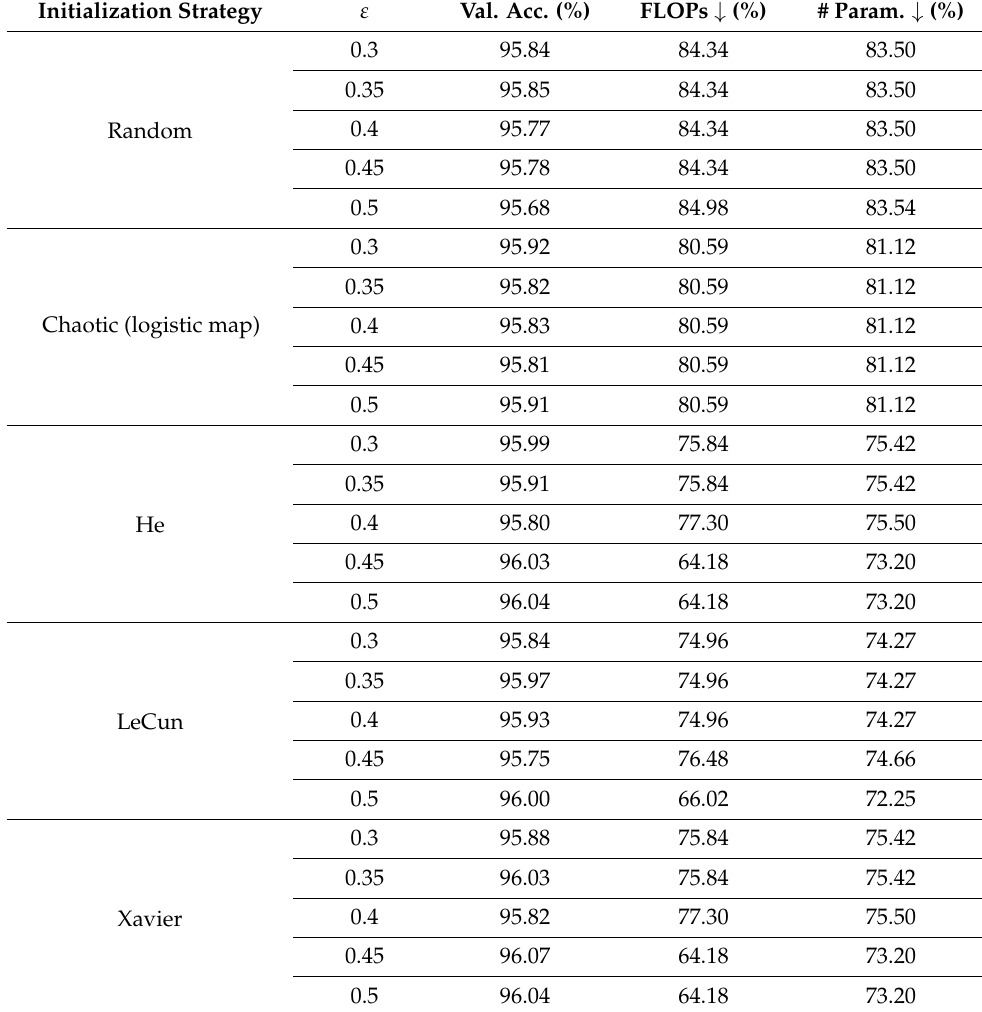
Table 7. Ablation study over the ε values for TernausNet on Inria